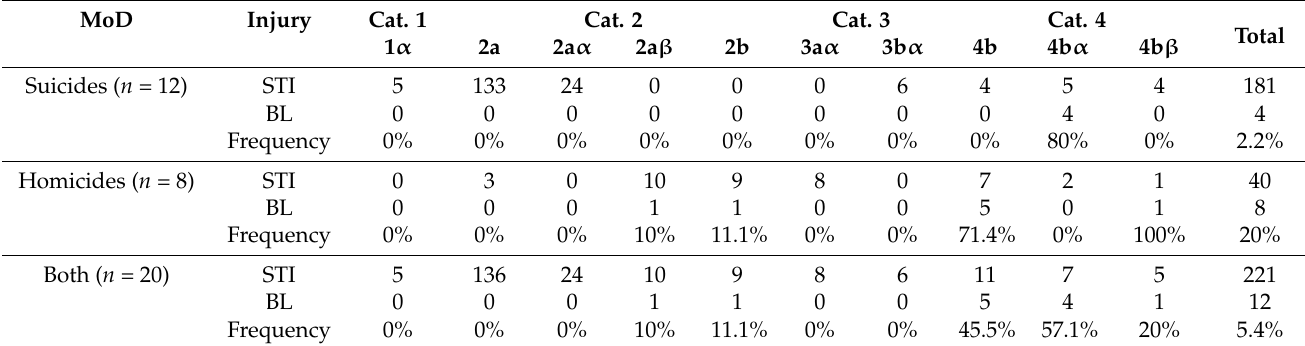
bined were not significant, with a p -value of 0.190.